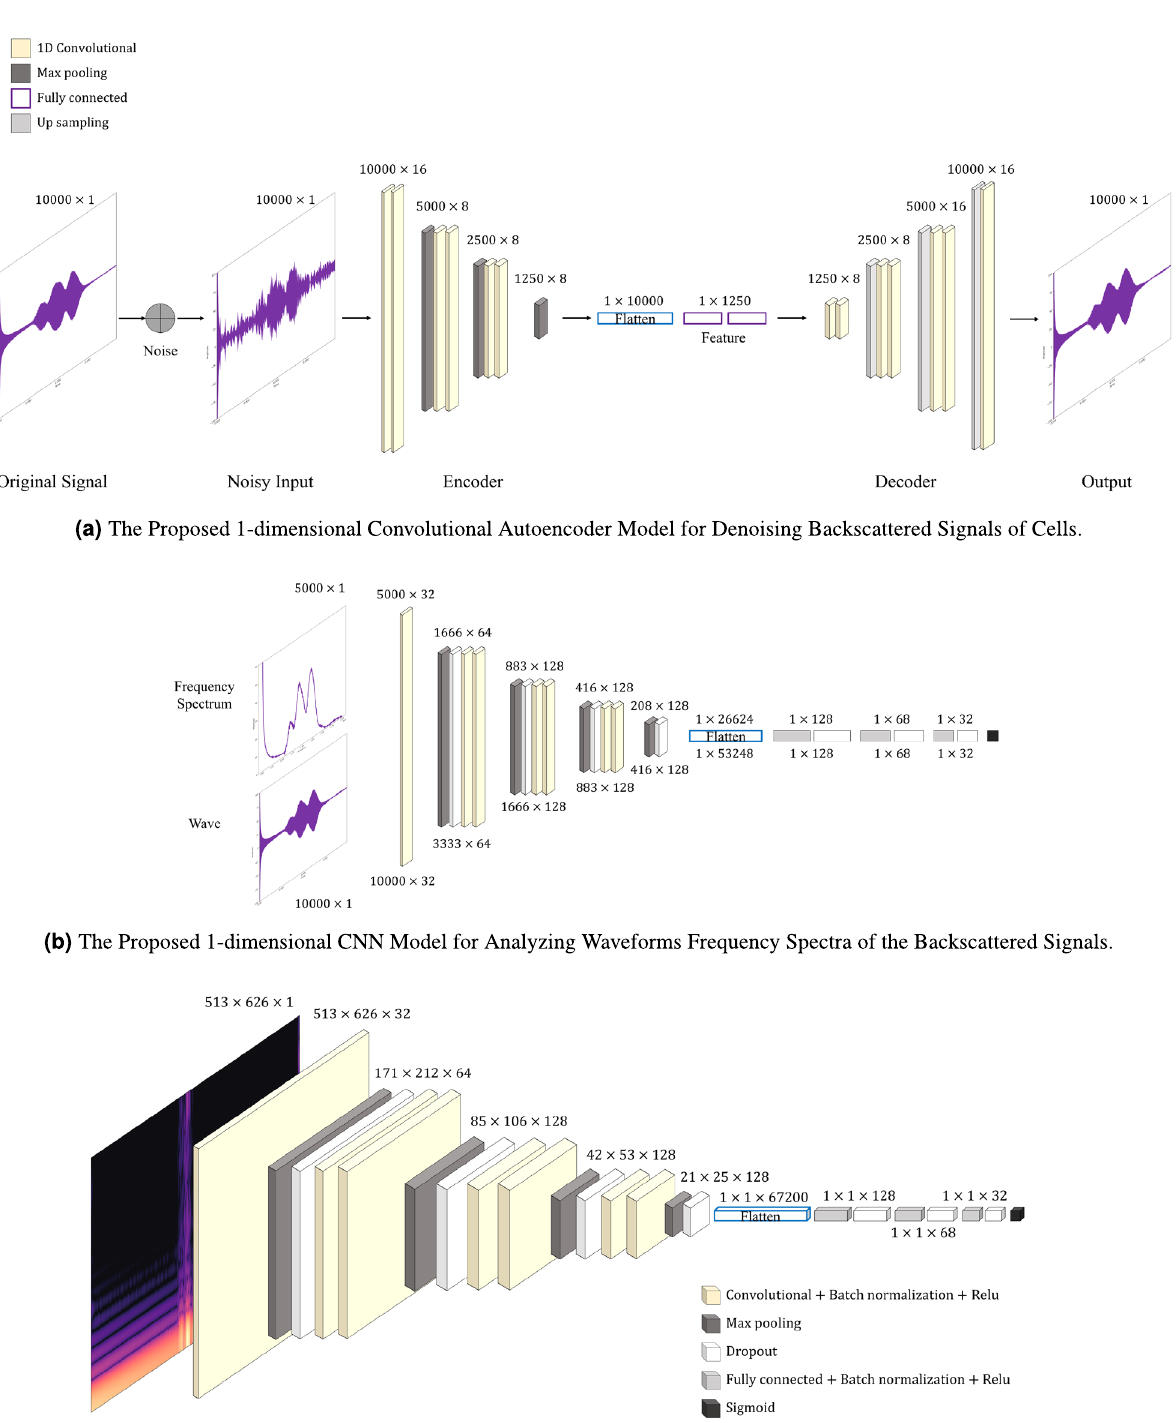
Figure 3. Structures of the proposed CNN models. The proposed system consists of three main components: the high-frequency ultrasound transducer in Fig. 1, denoising autoencoder in ( a ), and CNN classifiers in ( b ) and ( c ). The denoising autoencoder reduces noise and emphasizes latent features in backscattered signals collected by the high-frequency ultrasound transducers. The denoised signals were processed by FFT or STFT. In the waveform analysis, we did not conduct additional processing of the denoised signals. Then, the signals (or spectra/spectrograms) become inputs to the CNN models to classify cells according to cell